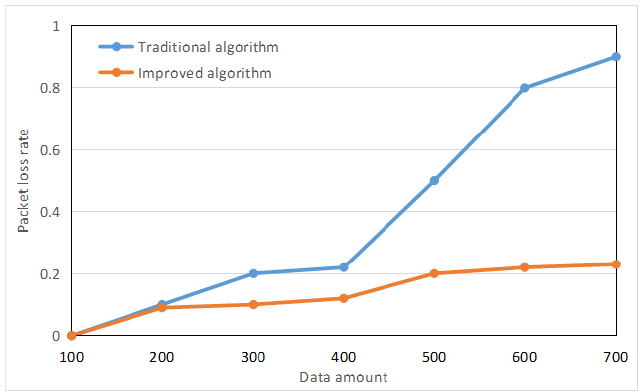
Figure 7. Execution curve for different data amount.